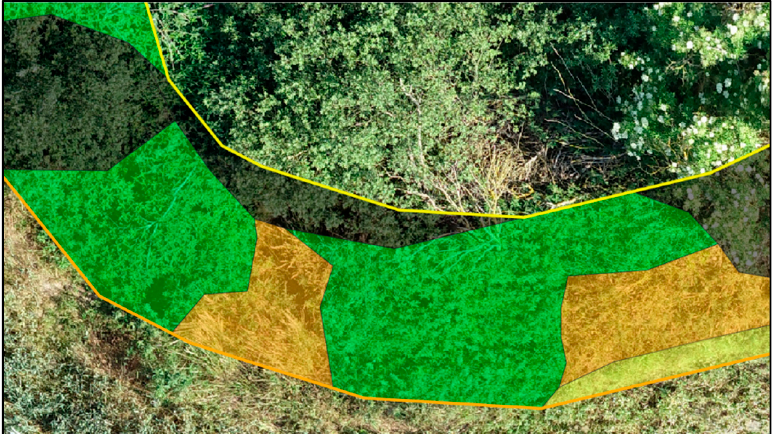
Figure 2. Cutout of the vegetation growing at the edge of one kettle hole investigated in 2019/2020. Image collected by an Unmanned Aerial System (UAS) in June 2020. Orthomosaics were created with this image by using Agisoft Metashape Professional 1.6.2 build 6205.